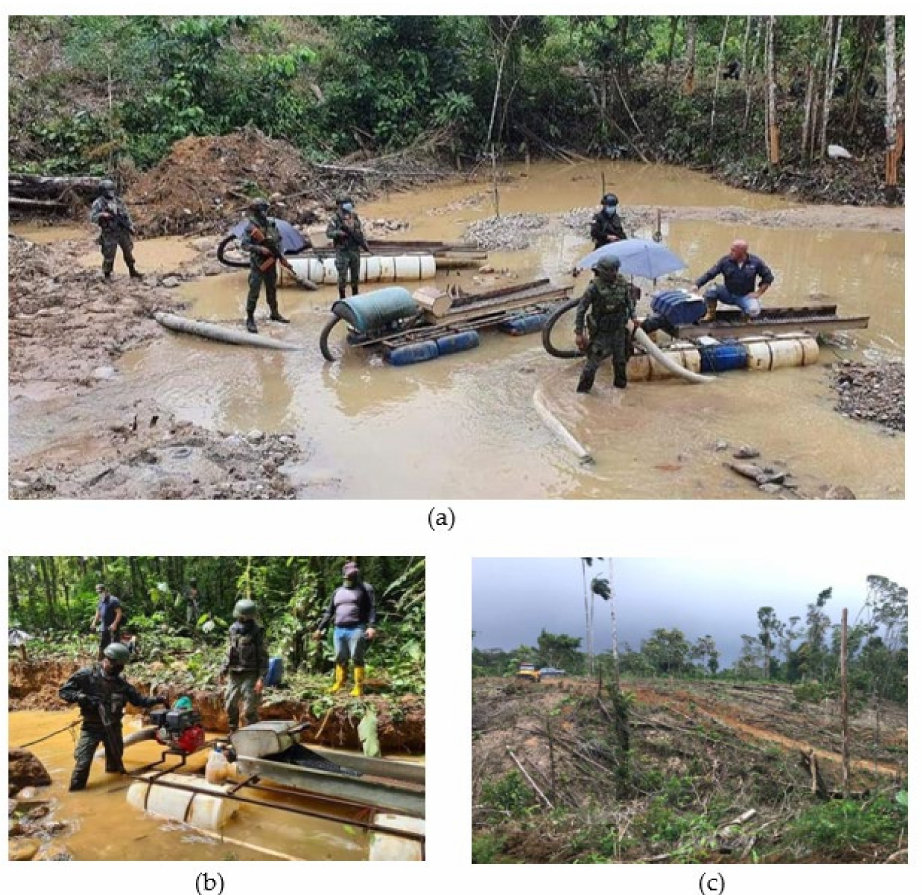
Figure 3. Illegal mining in the northern Amazon region of Ecuador. ( a ) Armed forces operations against artisanal gold mining in Sucumb í os (C á scales). ( b ) Operation and closure of illegal mining in Orellana (Alto Punino). ( c ) Impacts of illegal gold mining in Napo